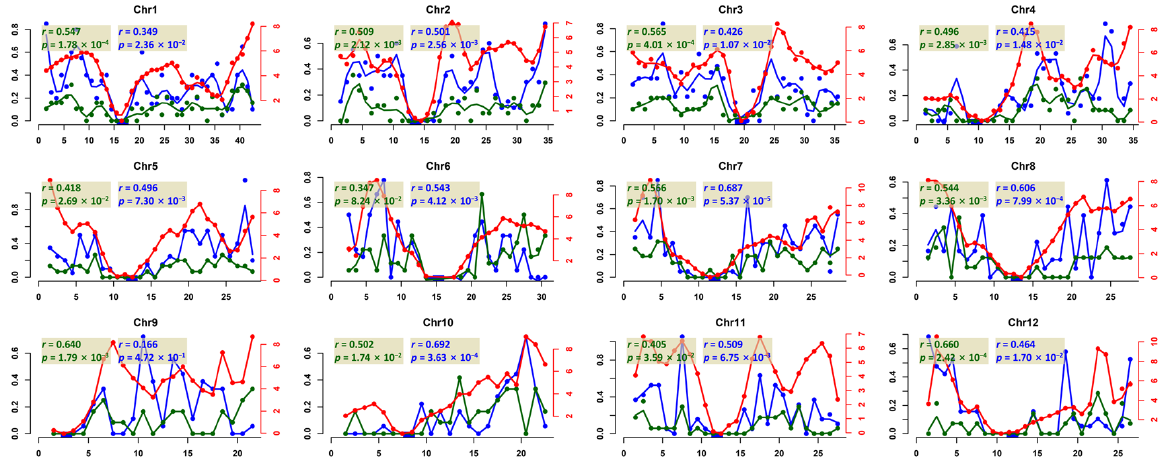
Figure 3. Distribution of local HE rates and local HR rate. Each dot stands for a 1Mb window. Local HE frequency (S2: green, S4: blue) and local HR rate (red) are shown in different colors. A smooth line was fitted using loess function (span = 0.2, degree = 2) for physical position with local HE frequency and HR rate, respectively. X -axis is the physical position. Y-axes are local HE rates ( left ) and local HR rates ( right ).